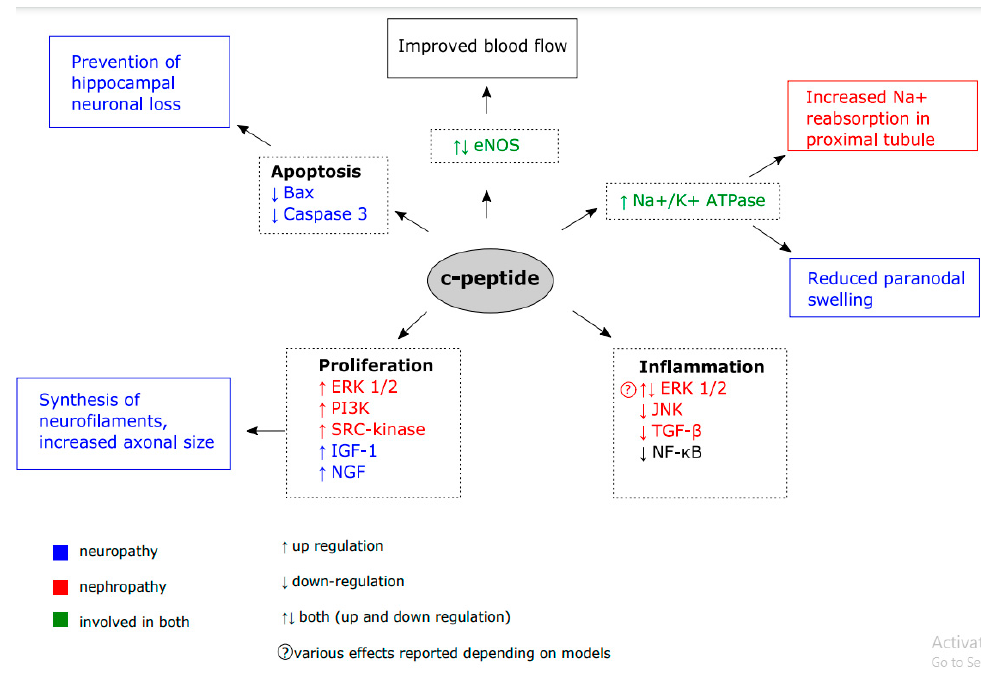
Figure 2. C-peptide treatment affects the function of cellular components involved in diabetic neuropathy (blue), diabetic nephropathy (orange) or both of these complications (green). As a result, C-peptide exerts beneficial effects on cells by reducing inflammation and apoptosis, improving blood flow, promoting proliferation and Na + reabsorption in proximal tubule.